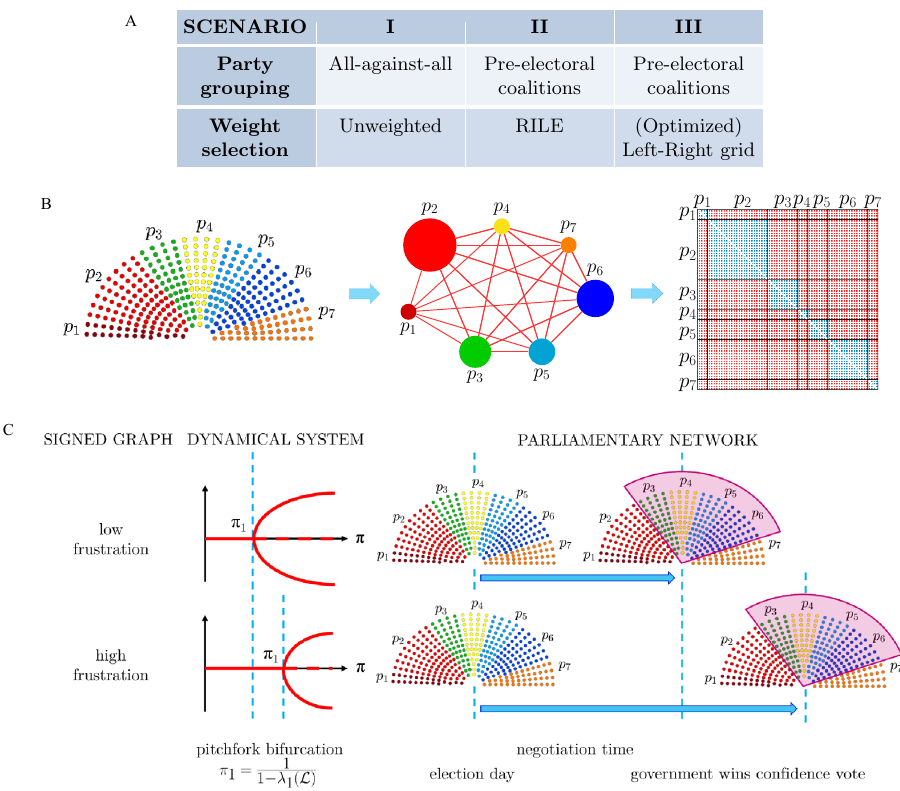
Figure 1. ( A ) The three different scenarios considered in this study. ( B ) Constructing a parliamentary network and the corresponding adjacency matrix in scenario I (all parties against all parties and weights equal to + 1 , in blue, and − 1 , in red). Each node p i represents a political party. See Supplementary Fig. 1A for scenario II and III . ( C ) Process of government formation described as a dynamical model of decision-making over signed networks: the higher is the frustration of the network, the higher is the value of the bifurcation point (cid:31) L ) = least eigenvalue of the normalized Laplacian of the signed graph). In turn, the higher is π 1 = 1 1 ( 1 − (cid:31) 1 ( L ) (